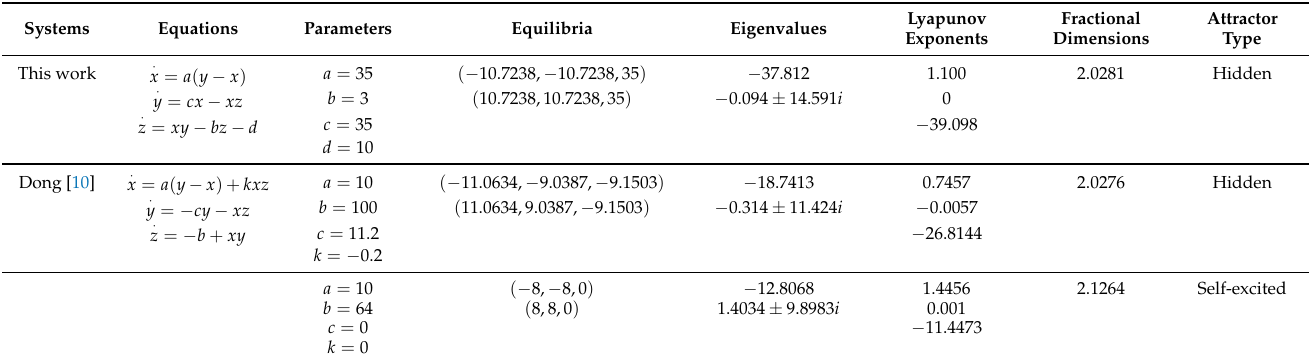
Table 1. Comparison with two chaotic systems with initial values ( 1,1,1 ) .